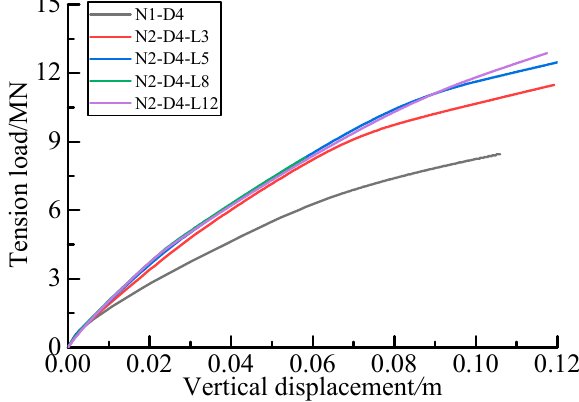
Figure 27. Uplift load-displacement curves ( D / d = 2, n = 2). Table 8. Uplift efficiency coefficient ( D / d = 2, n = 2).